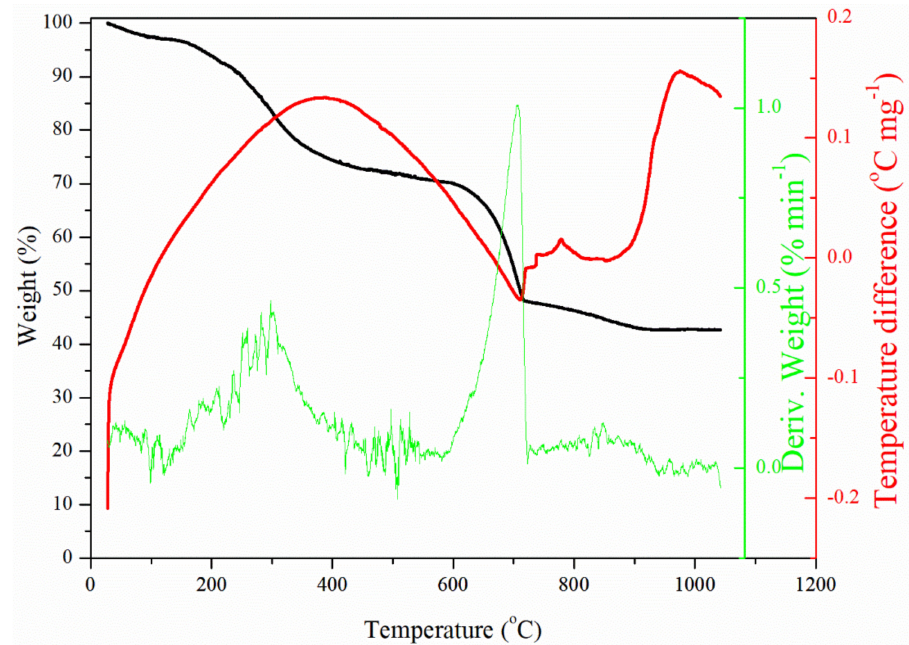
Figure 5. Phase transformations and thermal stability of the dried diatom biomass.